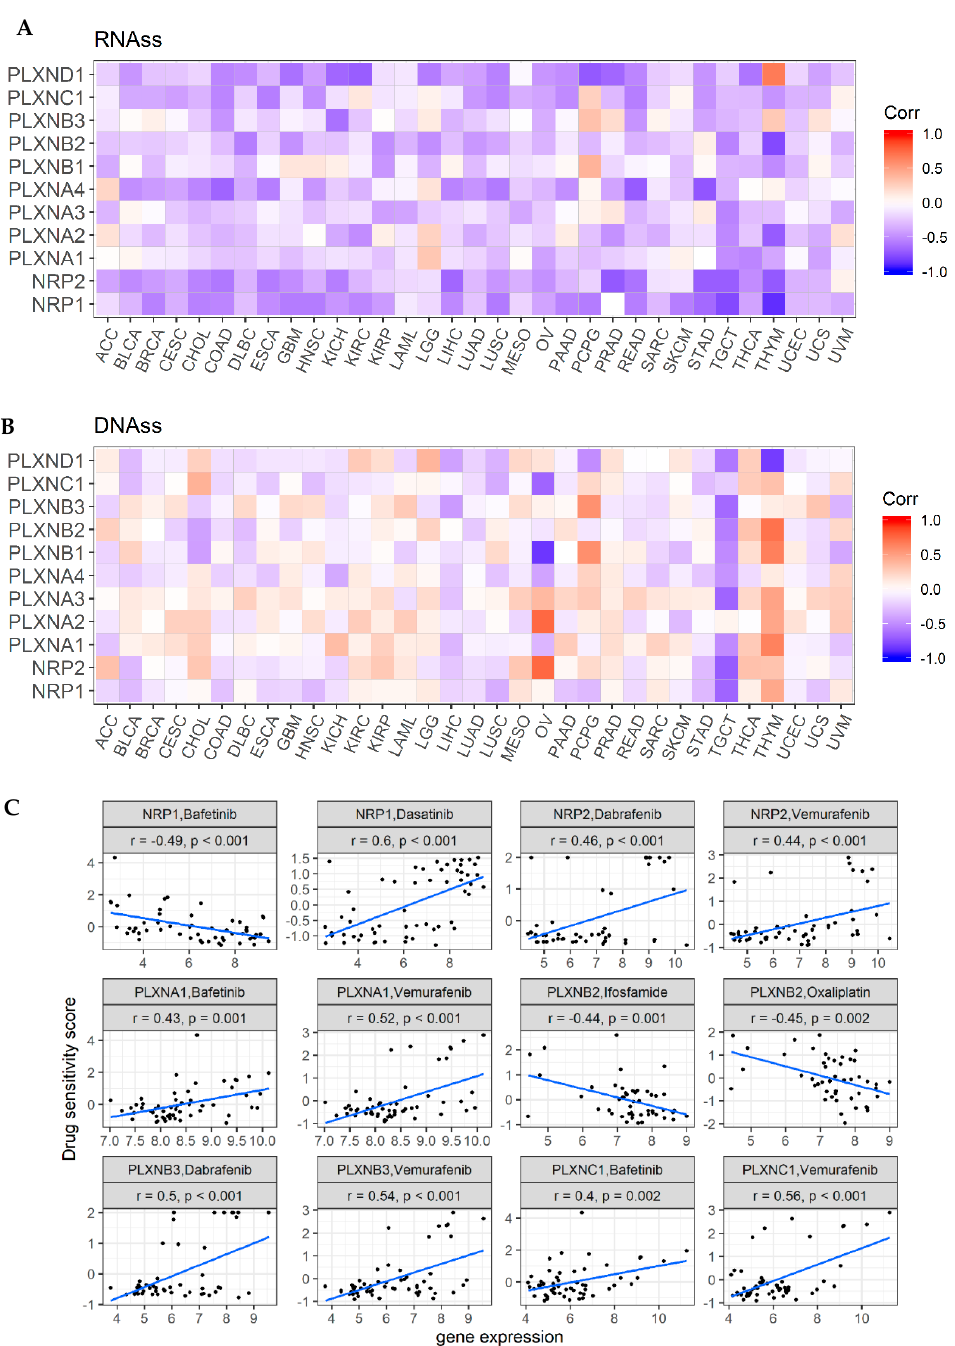
Figure 5. Association of expression of NRPs and PLXNs with tumor stemness and drug responses. ( A , B ). Correlation matrix between expressions of NRPs and PLXNs and cancer stemness scores RNAss ( A ) and DNAss ( B ), respectively, based on Spearman correlation tests. ( C ). Scatter plots to show the association between expression of NRPs and PLXNs and drug sensitivity ( Z -score from CellMiner interface) tested with Pearson Correlation using NCI-60 cell line data. p < 1 / (11 genes × 26 cancer types) = 0.003 for A and B, and p < 1 / 200 (drugs) = 0.005 for C was considered as